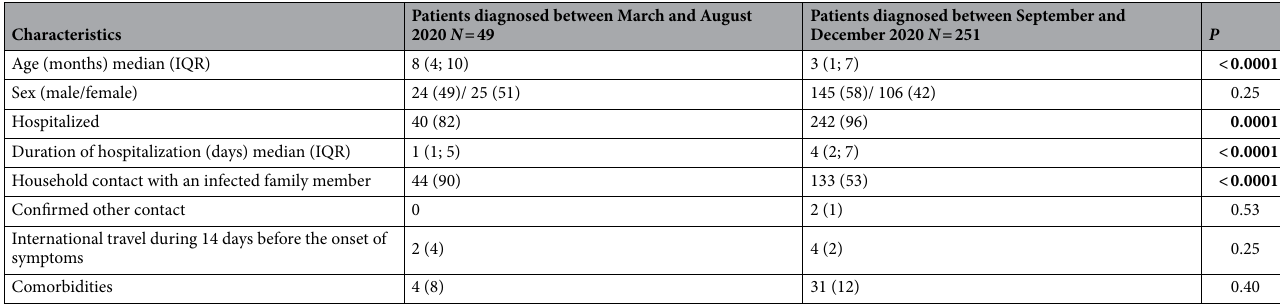
Table 2. Baseline epidemiological characteristics of infants with COVID-19 during the 1st and 2nd waves of the pandemic. Data are presented as Median (IQR) or n (%), as appropriate. Significance values are in Bold.